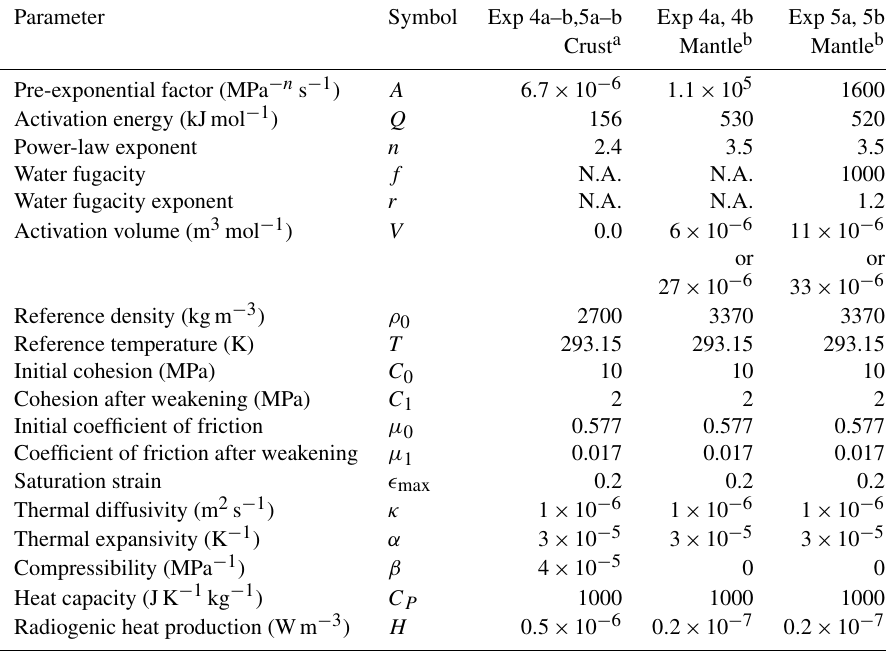
Table 1. Thermal and rheological